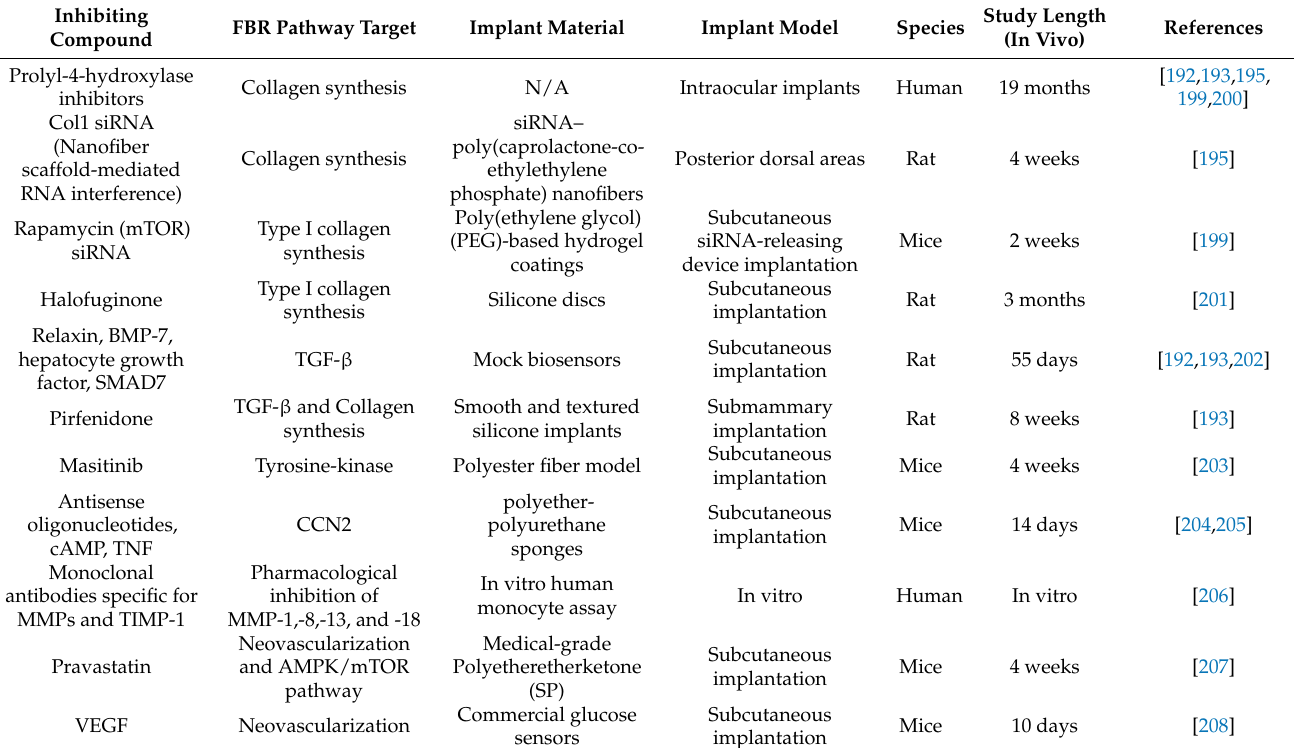
Table 1. Current strategies to target the fibrotic phase of the